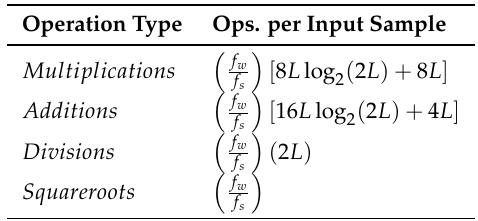
Table 1. Number of operations required by the proposed Zero Forcing Block Adaptive Filter (ZF-BAF) algorithm per input